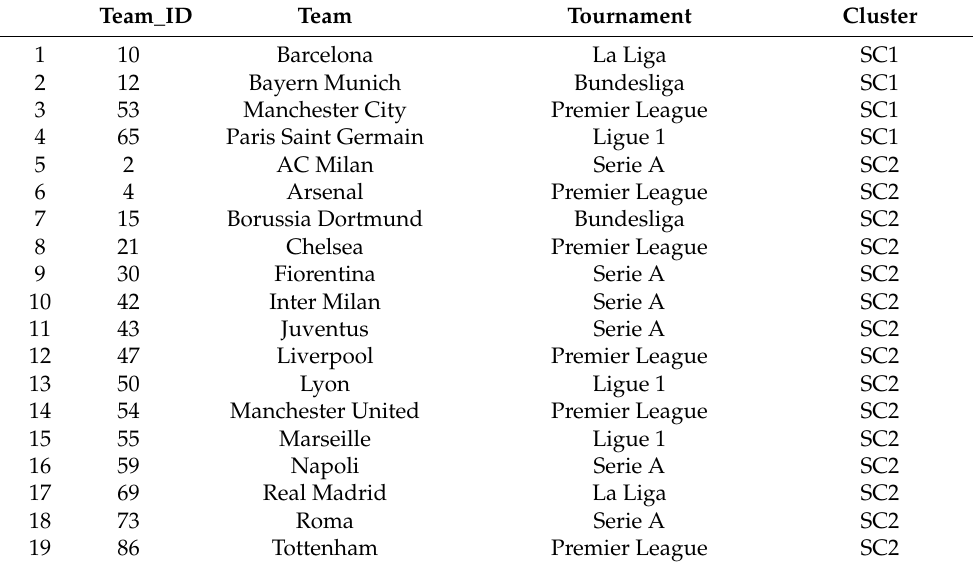
Table 4. The Laplacian eigenvector approach to a new elite European Super League. Team_ID Team Tournament